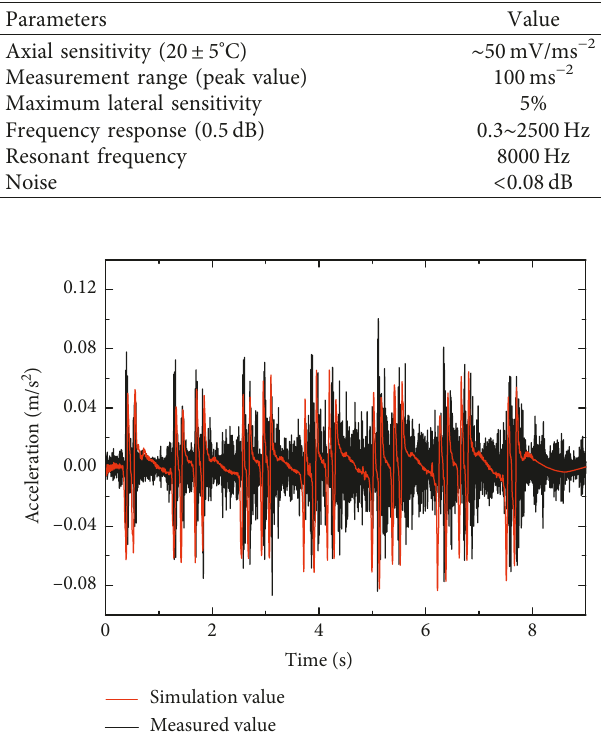
Figure 10: Comparison of measured and simulated acceleration in the time-domain curve.